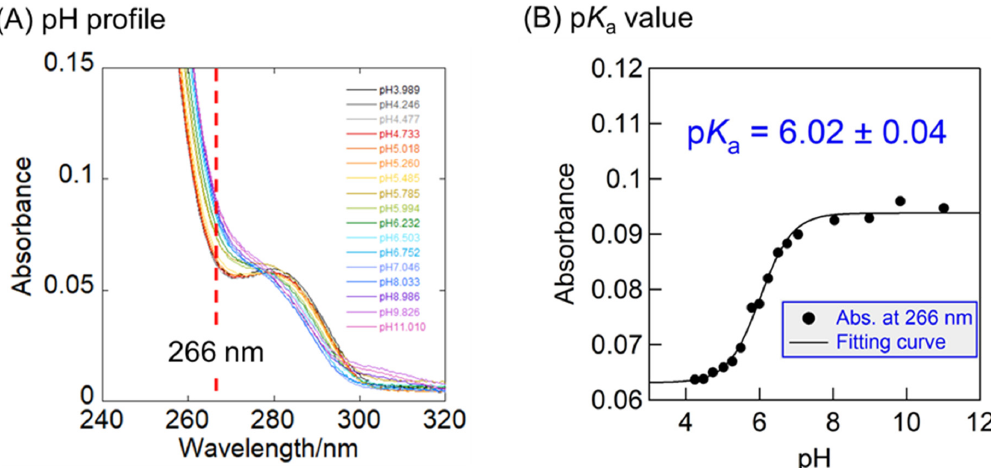
Figure 7. UV–Vis absorbance results for benzoxaborole 5 in PBS from pHs of 4.0 to 11.0. [compound 5 ] = 10.0 × 10 − 6 M. ( A ) UV–Vis absorption spectra under various pH conditions. ( B ) Summary at 266 nm from which the p K a value was calculated.